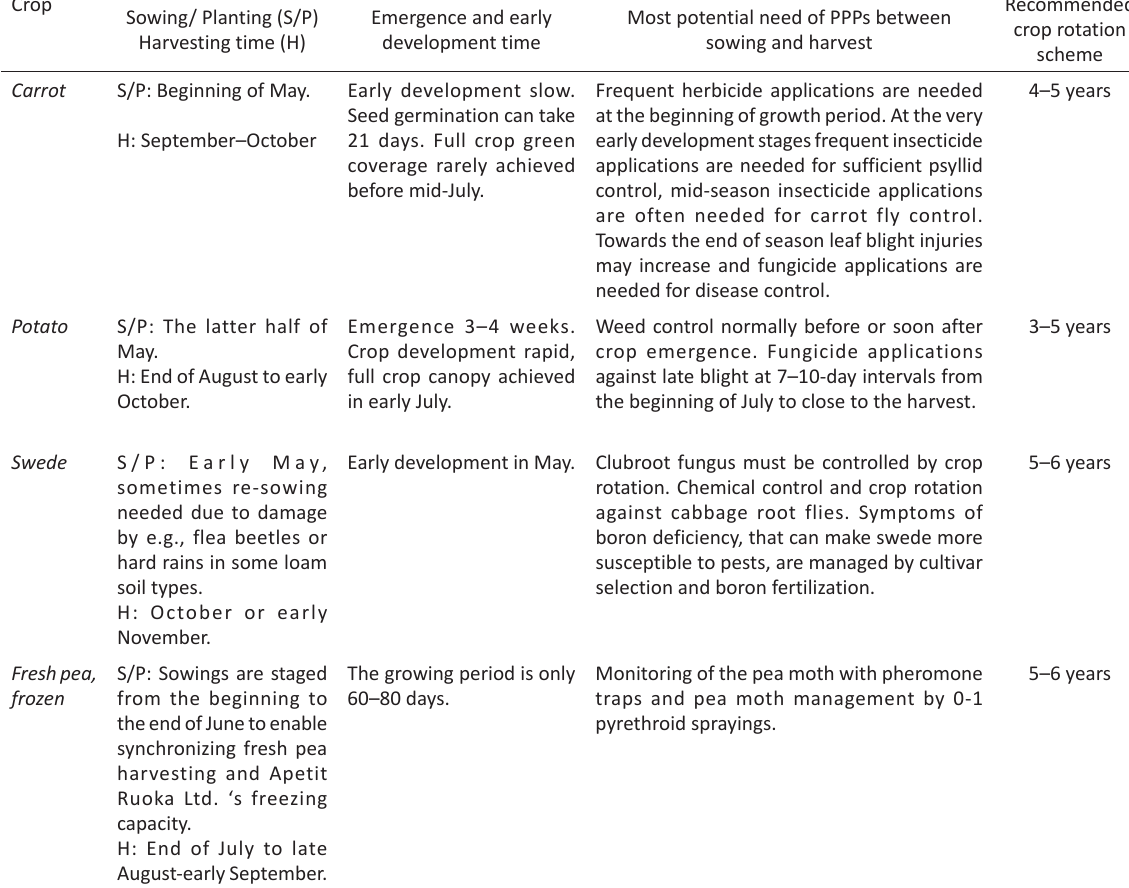
Table 1. General recommendations for crop management for carrot, potato, swede and fresh pea crops in Finland (Natural Resources Institute Finland 2021c) Crop Sowing/ Planting (S/P) Harvesting time (H)